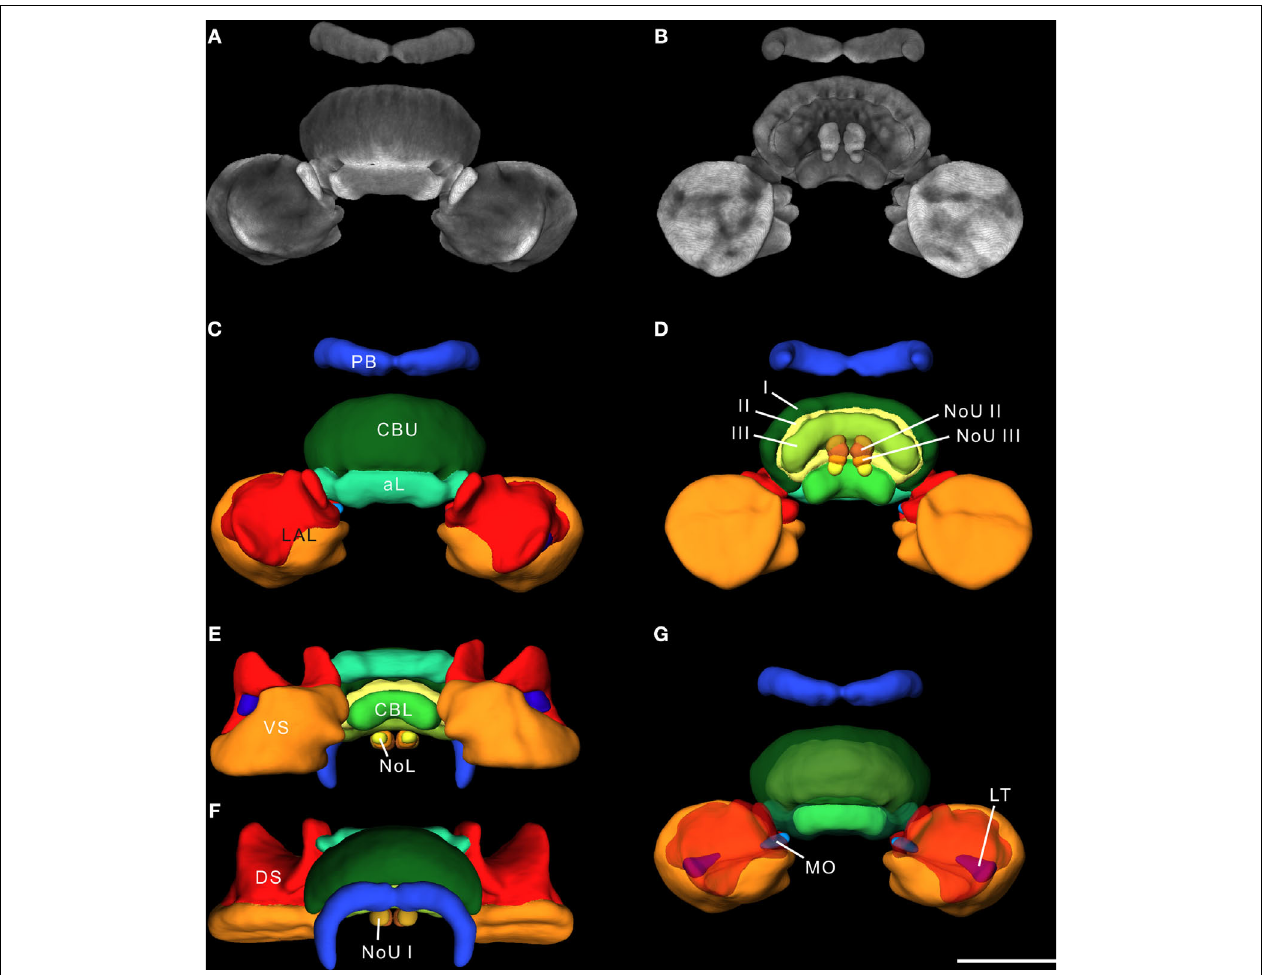
FIGURE 3 | The 20-animal standard central complex calculated using the ISA method. (A,B) 3D reconstruction of the standardized image stack by direct volume rendering. For visualization, synapsin labeling in brain areas surrounding the image data was deleted. (A) 3D visualization of the standardized CLSM image stack from anterior. (B) Posterior view of the standard central complex image data. (C–G) Surface reconstruction of all 22 segmented neuropils from different perspectives. (C) Anterior view (D) posterior view (E) ventral view